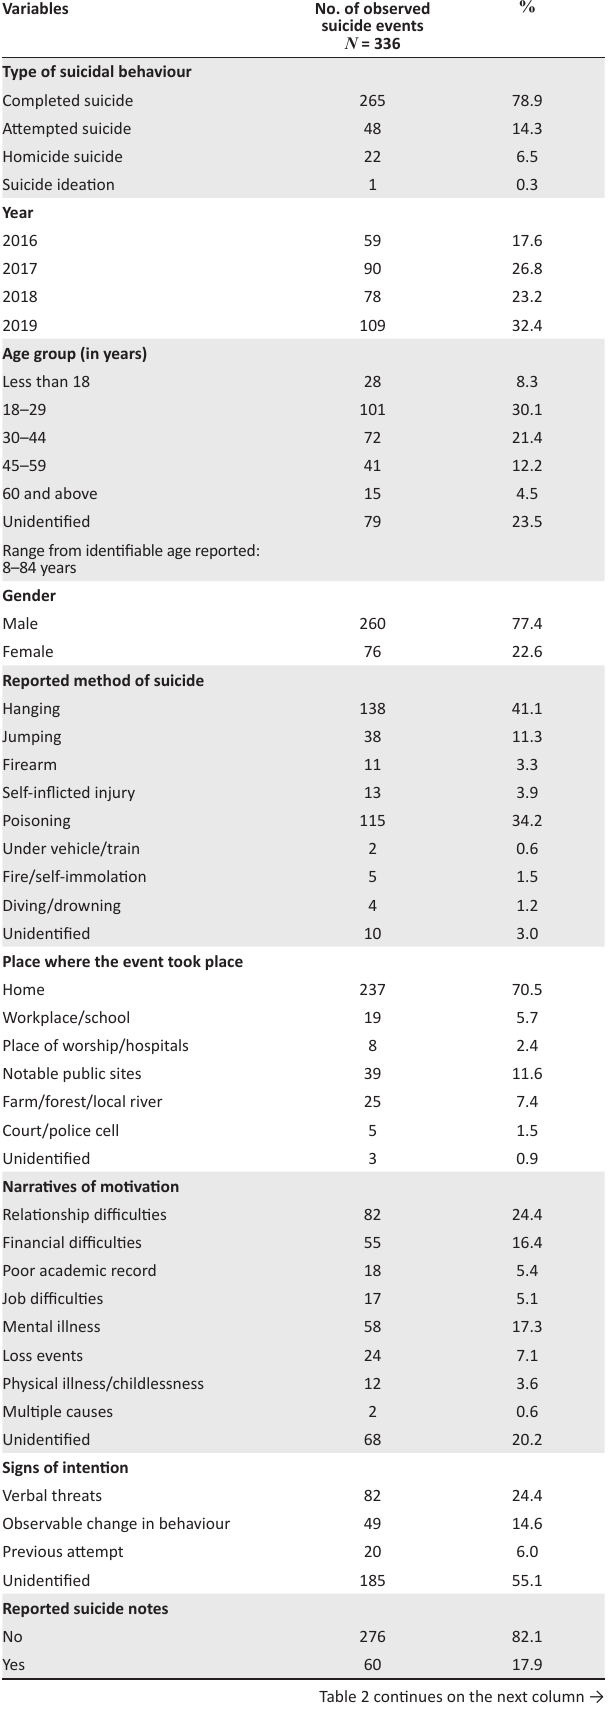
TABLE 2 (Continues...): Characteristics of suicide events as reported by media reports of Nigerian news media from January 2016 to December 2019.